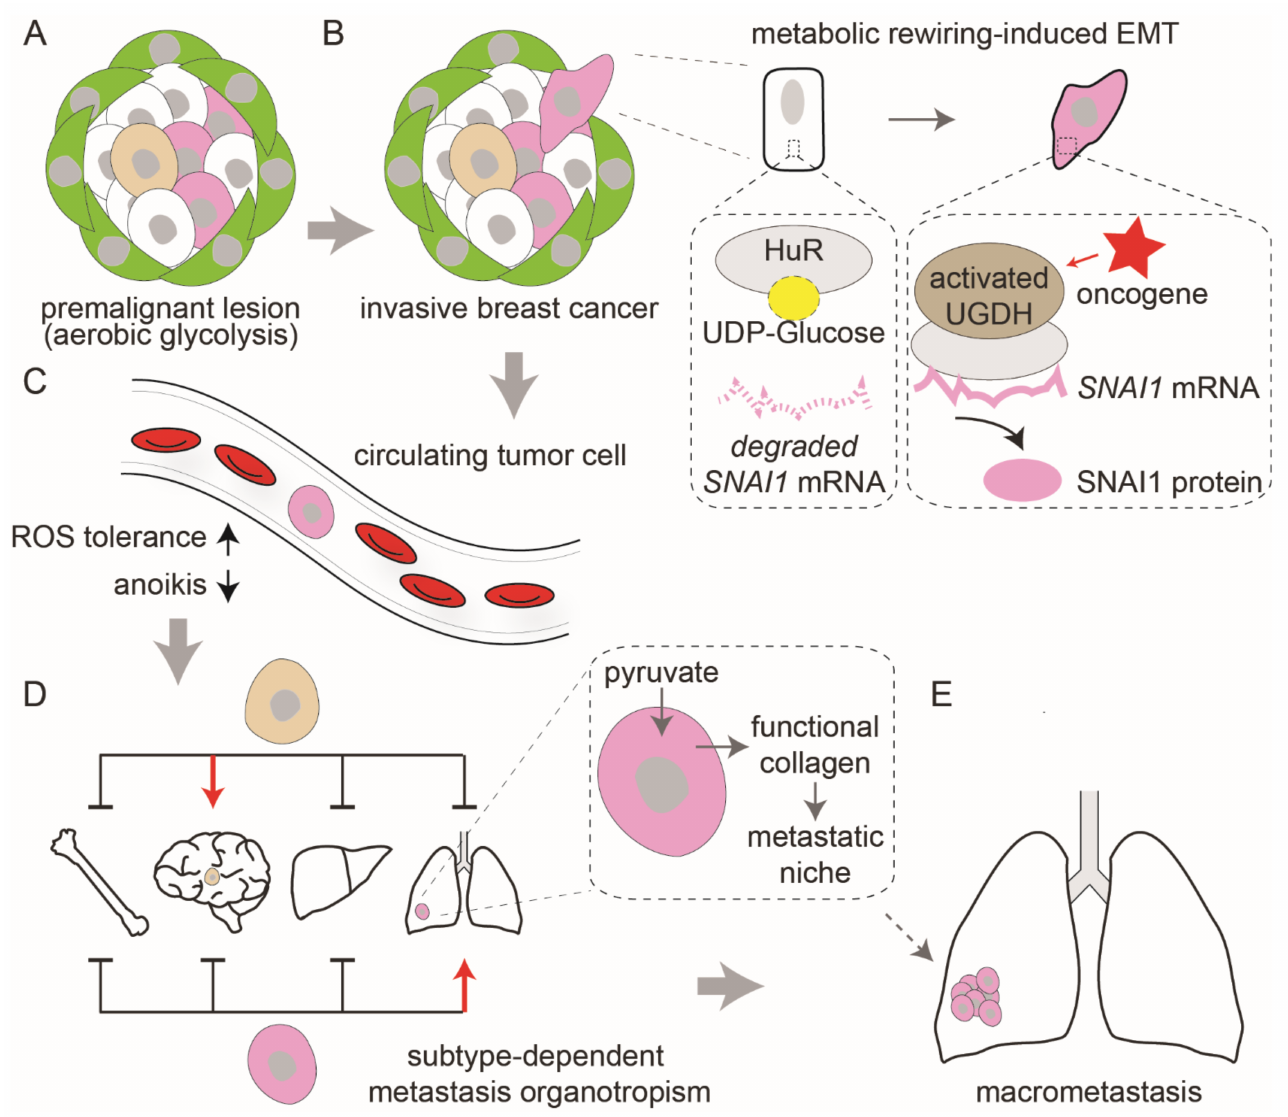
Figure 2. Tumor metabolic rewiring supports the metastatic cascade. ( A ) The Warburg effect is commonly observed in premalignant lesions. ( B ) Metabolites can affect cancer-cell epithelial–mesenchymal transition (EMT). In normal cells, binding of the HuR to a UDP-glucose destabilizes SNAI1 mRNA. In tumor cells, oncogene activities enable UGDH to bind to HuR, stabilizing SNAI1 mRNA and facilitating EMT process. ( C ) Circulating tumor cells develop resistance to oxidative stress and anoikis. ( D ) Breast cancer subtypes differ in their metastatic behavior. Subtype-selective pyruvate metabolism drives ECM remodeling in the lung metastatic niche. ( E ) The growth-promoting metabolic network is activated in